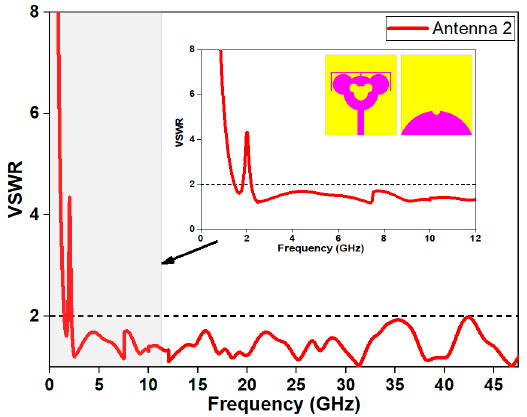
Figure 3. Phase 2: VSWR of the single band-notched antenna.